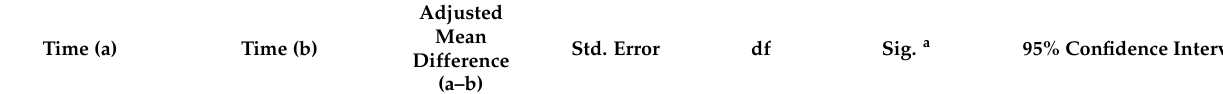
Table A3. Pairwise comparison of the mean oPMN counts across the four time points.